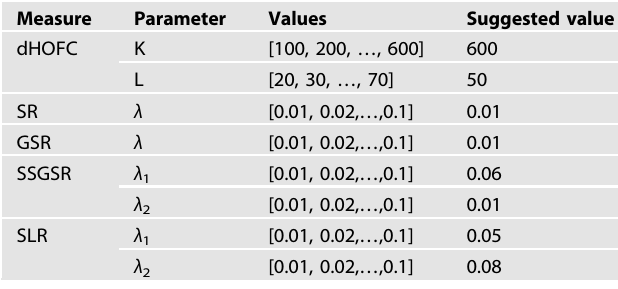
Table 3. Parameter combinations and optimal parameters for different